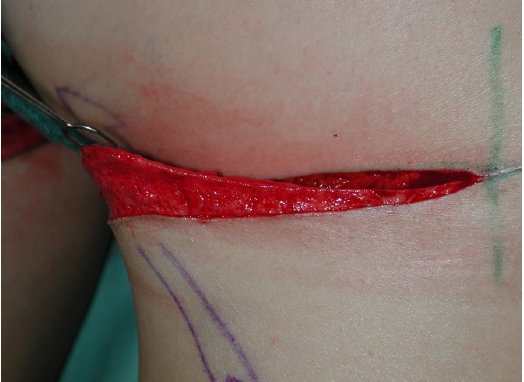
Figure 13. Underminig and anchoring to the ischial tuberosity or deep fascia using resorbable sutures.